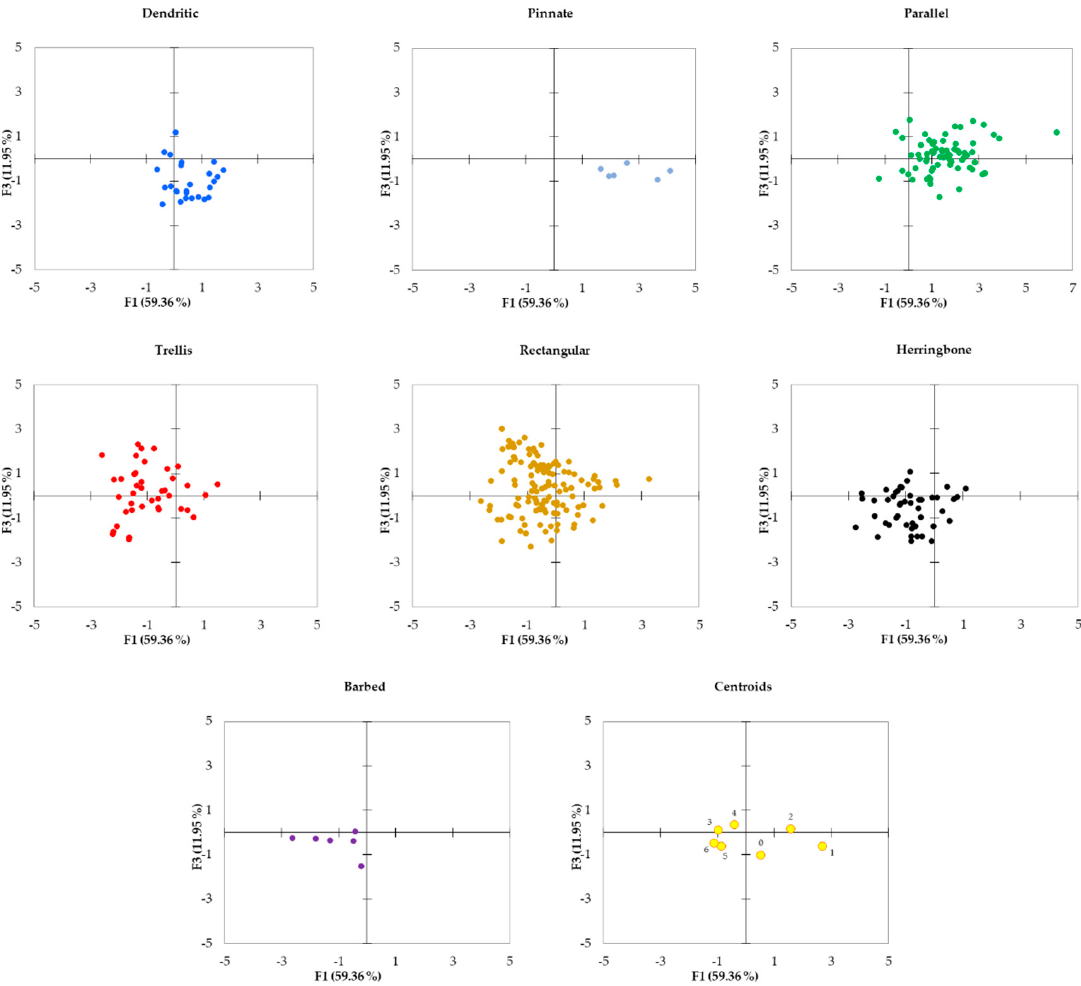
Figure 9. Distribution of the observations and centroids of each type of drainage network pattern in F1–F3 score plots (0 = Dendritic, 1 = Pinnate, 2 = Parallel, 3 = Trellis, 4 = Rectangular, 5 = Herringbone, 6 = Barbed).